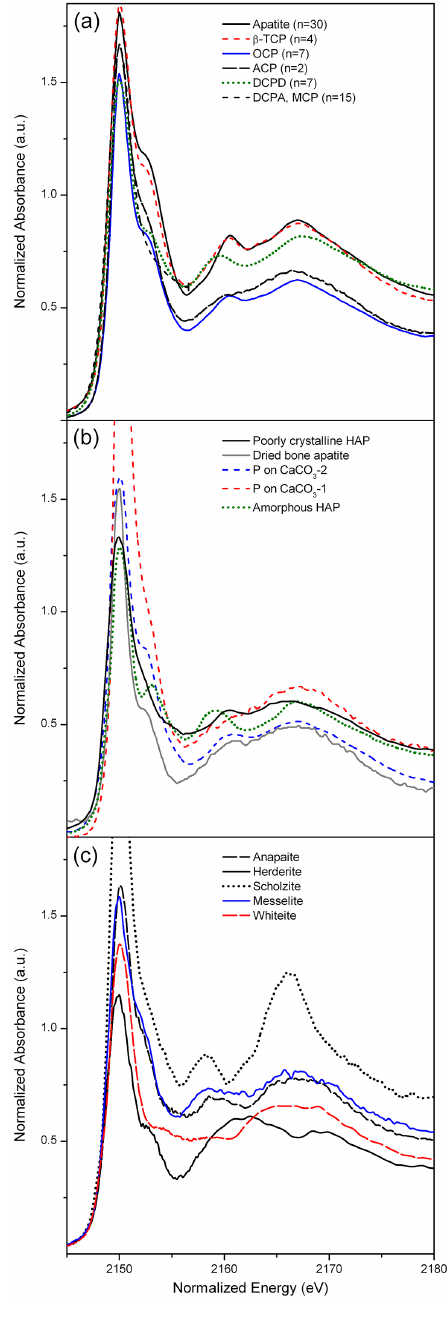
Fig. 2. First-derivative normalized P K-edge XANES spectra of Ca-P reference compounds. (a) Averaged spectra for apatites, β -tricalcium phosphate ( β -TCP), octacalcium phosphate (OCP), amorphous calcium phosphate (ACP), brushite (DCPD), monetite (DCPA) and monocalcium phosphate (MCP). (b) Spectra for poorly crystalline and amorphous apatite, bone apatite and P adsorbed on CaCO 3 . (c) Spectra of different non-apatitic Ca-P minerals (Ingall et al., 2011). Oxygen oscillations in (c) were not adjusted to ca. 2167eV due to unusual spectral